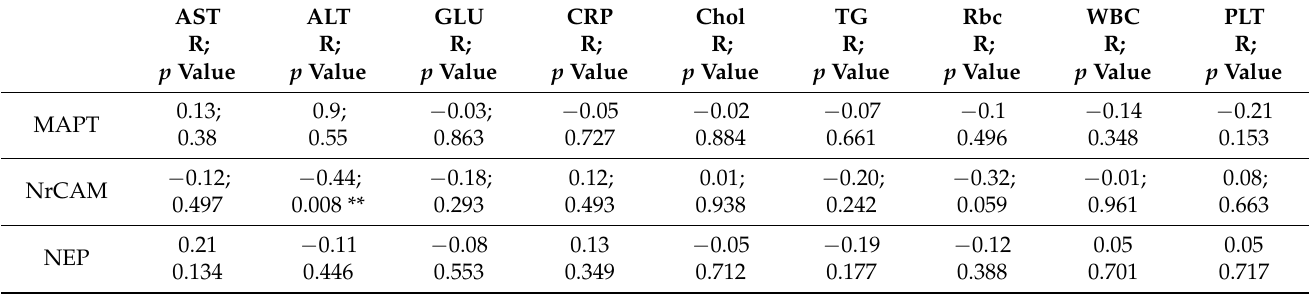
Table 3. Correlations between the proteins and selected laboratory parameters before therapy.